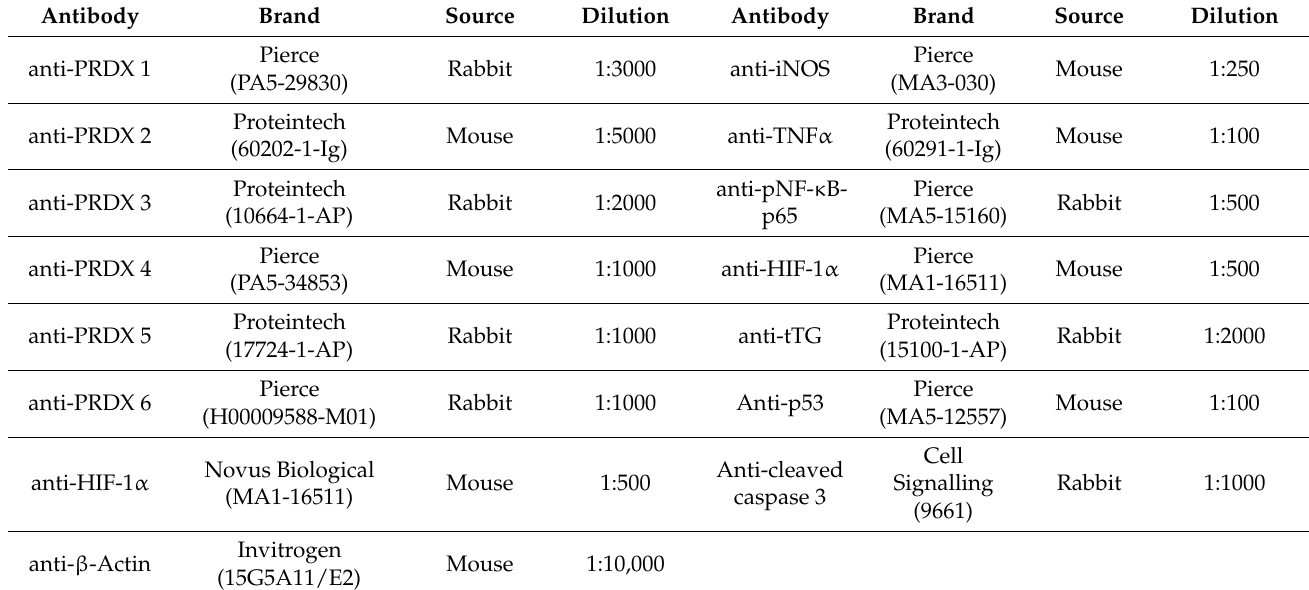
Table 3. Source, dilution ratio, and brand names of the primary antibodies used in the Western blot